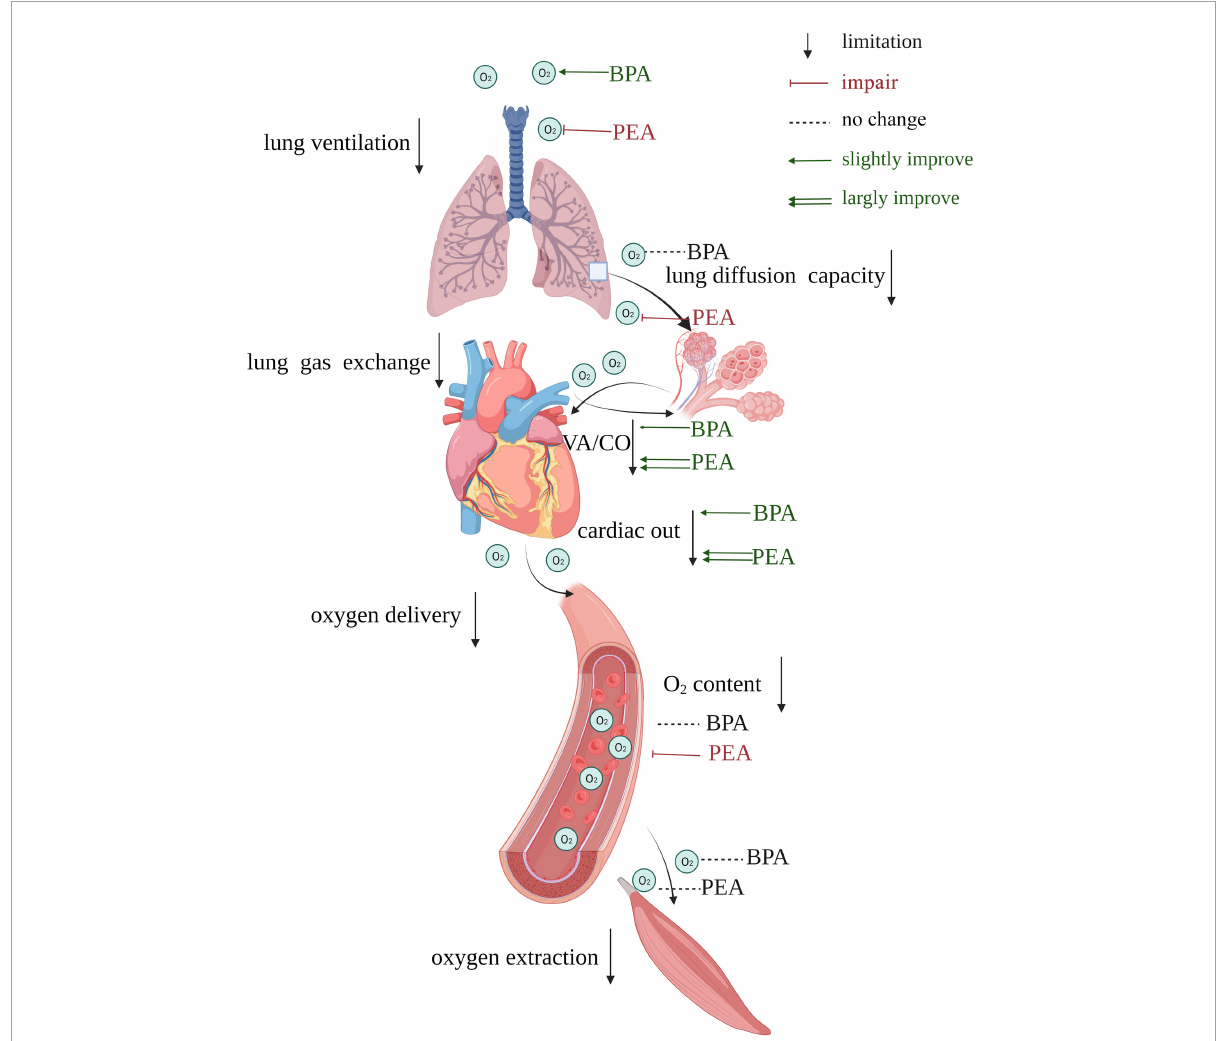
FIGURE4 Summary of the effects of PEA versus BPA on the oxygen pathway of patients with CTEPH. Impairments exit in both lung ventilation, lung gas exchange, oxygen delivery, and oxygen extraction. BPA could improve lung ventilation, while PEA causes damage to it. VA/CO gets more improvement in patients receiving PEA than those receiving BPA. PEA impairs lung diffusion capacity, while BPA does not affect it. The cardiac output of patients receiving PEA gets more improvement than those receiving BPA, and PEA could reduce the oxygen content. There is no significant change in oxygen extraction after PEA or BPA. VA/CO, alveolar ventilation-to-cardiac output